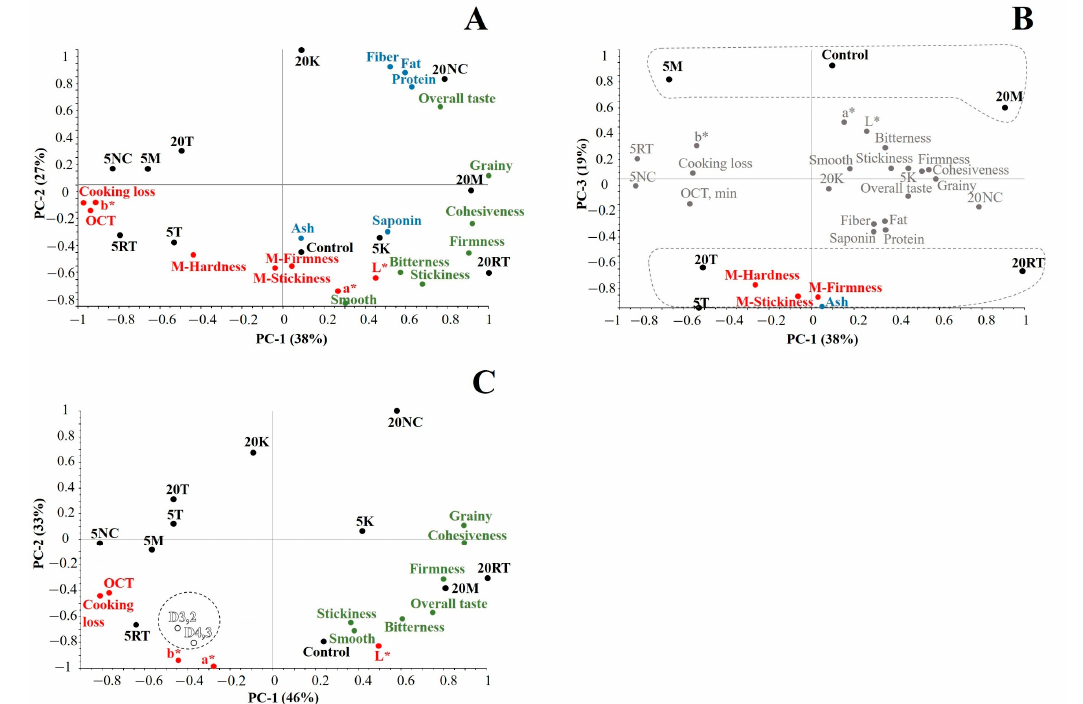
Figure 5. Principal component analysis bi-plots for compositional, physicochemical, mechanical, and sensory properties ( A , B ) accounting for a total variance of 84% (PC-1, PC-2, and PC-3). Principal component analysis bi-plots for physicochemical and sensory properties ( C ) with emphasis on particle diameters (D3,2: Surface area moment mean; D4,3: volume moment mean); this plot accounts for a total variance of 79% (PC-1 and PC-2). Factor scores: 5% quinoa var. kuchivila (5 K), 20% quinoa var. kuchivila (20 K), 5% quinoa var. mistura (5 M), 20% quinoa var. mistura (20 M), 5% quinoa var. negra collana (5 NC), 20% quinoa var. negra collana (20 NC), 5% quinoa var. rosada taraco (5 RT), 20% quinoa var. rosada taraco (20 RT), 5% quinoa var. titicaca (5 T), 20% quinoa var. titicaca (20 T), 100% buckwheat (control). Factor loadings for physicochemical and mechanical properties (RED): a* (green-red colour component); b* (blue-yellow colour component); Cooking loss; L* (lightness); M-Firmness (firmness of cooked pasta measured through mechanical methods); M-Hardness (hardness of cooked pasta measured through mechanical methods); M-Stickiness (stickiness of cooked pasta measured through mechanical methods); OCT (Optimal cooking time). Factor loadings for sensory properties (GREEN): Cohesiveness; Firmness; Grainy; Smooth; Stickiness; Overall taste; Bitterness. Factor loadings for compositional characteristics: Ash; Fat; Fiber; Protein;